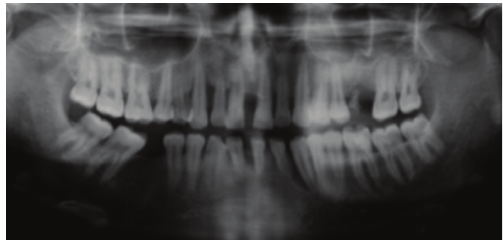
Figure 11: Orthopantomogram showing generalized bone loss with advanced vertical defect in 13 and 33